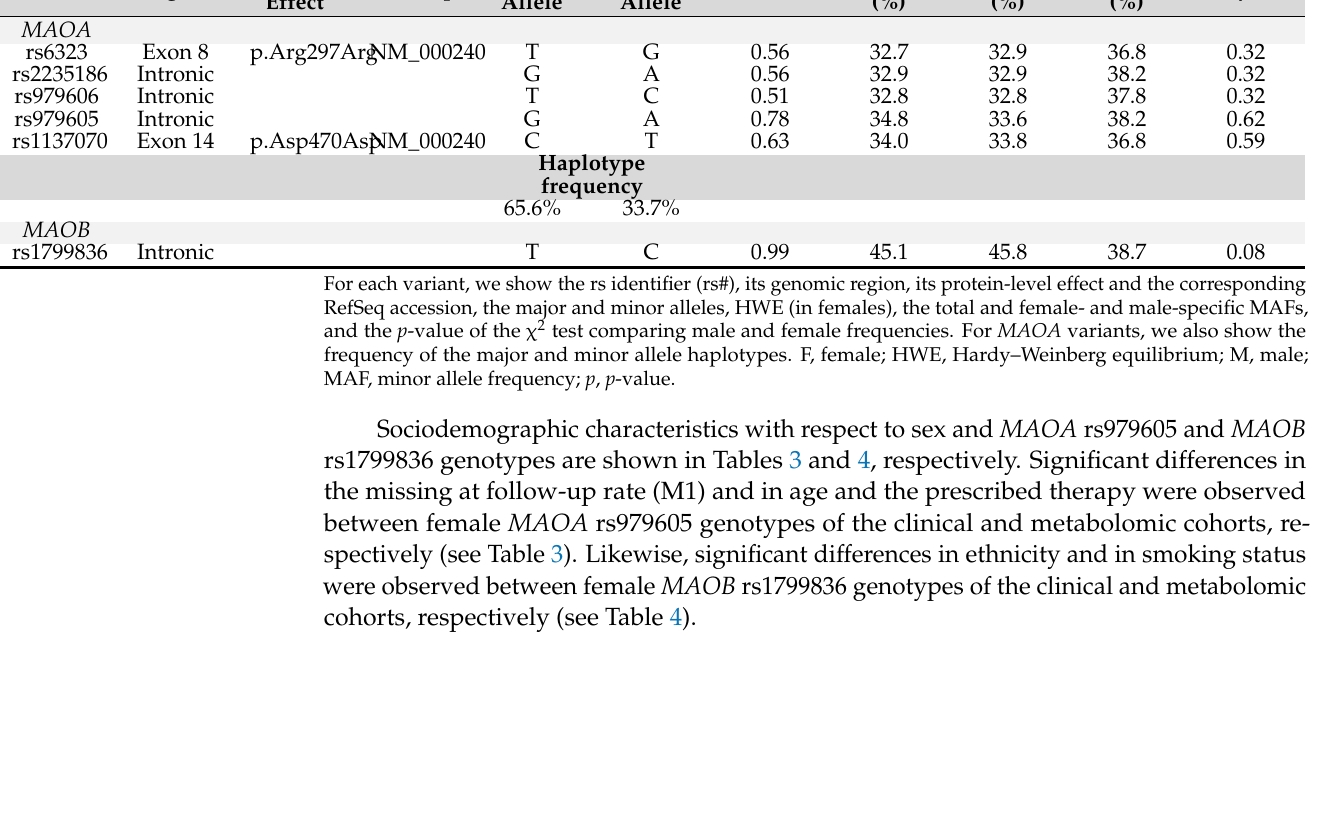
Sociodemographic characteristics of the whole sample and in males and females of the clinical and metabolomic cohorts. ATD, antidepressant drug; ECT, electroconvulsive therapy; HDRS, 17-item Hamilton Depression Rating